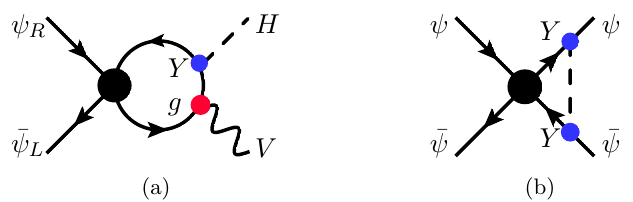
Figure 2 . Some leading diagrams contributing to (magnetic) dipole moments and (cid:13)avor transitions. (cid:13)avor-violating process proceeds via the top, and the scale associated to certain operators needs to be above 1 TeV [49]. Some of the potentially problematic operators,